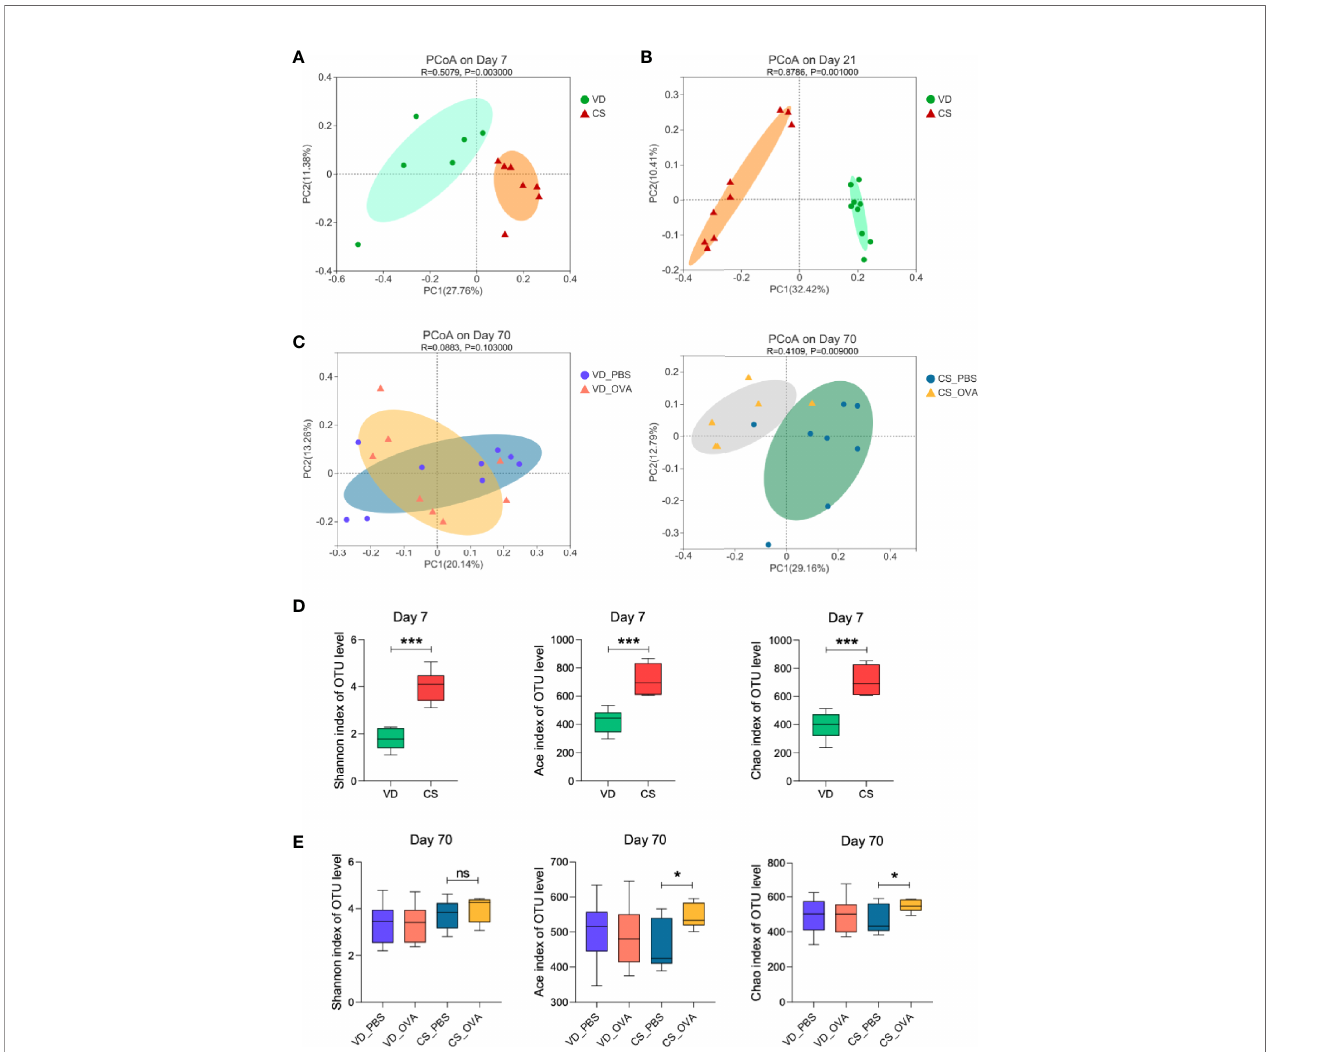
FIGURE 3 | Mode of delivery affects the composition of the microbiota. (A – C) PCoA of fecal microbiota composition in VD and CS rats on Days 7 (A) , 21 (B) , and 70 (C) . PCoA is based on binary-jaccard distance. ANOSIM and 999 times permutation tests were utilized. (D, E) Shannon, Ace, and Chao indexes on Days 7 (D) and 70 (E) . Data are expressed as means ± SEM, and statistical signi fi cance was determined by two-sided Student ’ s t-test or one way ANOVA. * P < 0.05, *** P < 0.001; ns, no signi fi cance. (A, D) Day 7 (VD n = 6, CS n =7). (B) Day 21 (VD n = 9, CS n =9). (C, E) Day 70 (VD_PBS n = 9, VD_OVA n = 8, CS_PBS n = 8, CS_OVA n = 6). VD, vaginal delivery; CS, cesarean